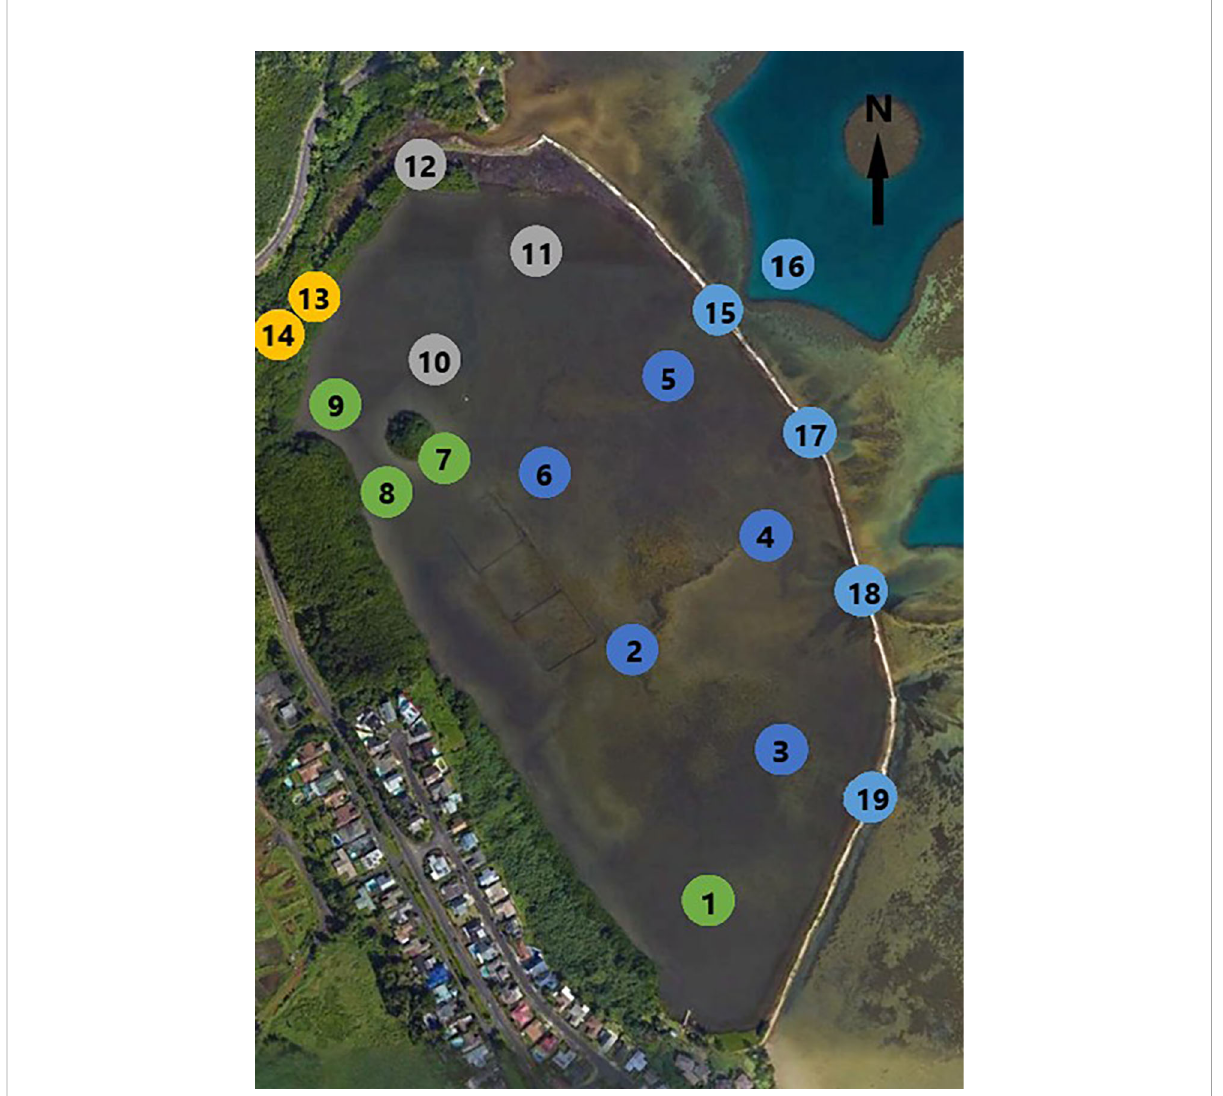
FIGURE 2 He ’ eia Fishpond, sampling locations numbered: in pond 1-11; Stream facing ma ̄ ka ̄ ha ̄ 12 & 13; Ocean facing ma ̄ ka ̄ ha ̄ 15, 17, 18, 19; Stream and Ocean endmembers 14 & 16. Station color matches spatial groupings identi fi ed in Figure 3. (Image from Google Earth modi fi ed by Evan